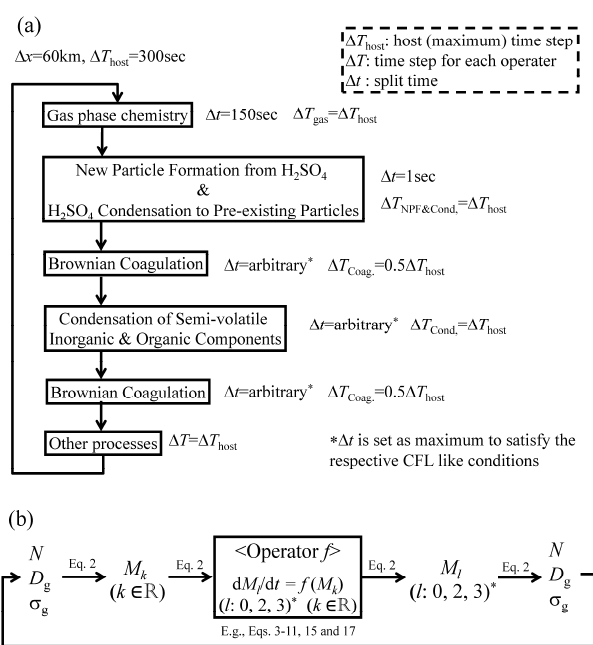
Figure 2. Schematic illustration of (a) operator splitting and time splitting for the RAQM2 2 Fig. 2. Schematic illustration of (a) operator splitting and time split- aerosol dynamics module and (b) changes in moments and LNSD parameters when passing 3 ting for the RAQM2 aerosol dynamics module and (b) changes in each process operator. 4 moments and LNSD parameters when passing each process opera- tor.